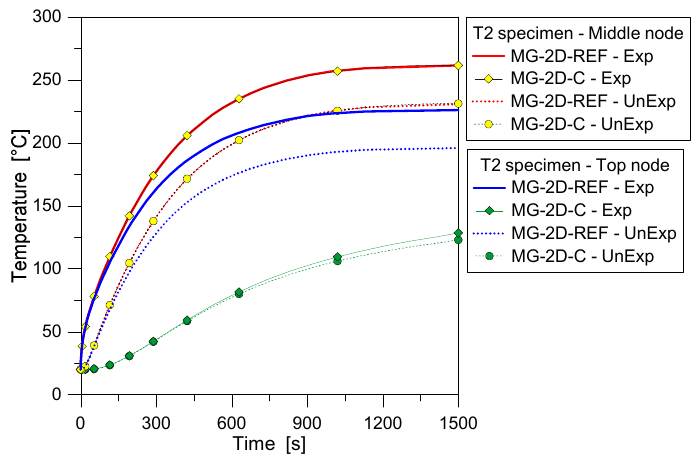
Figure 15. FE results (ABAQUS, 2D) for the MG specimen T2, including mechanical restraints. Temperature history comparisons at the middle and top edge nodes.